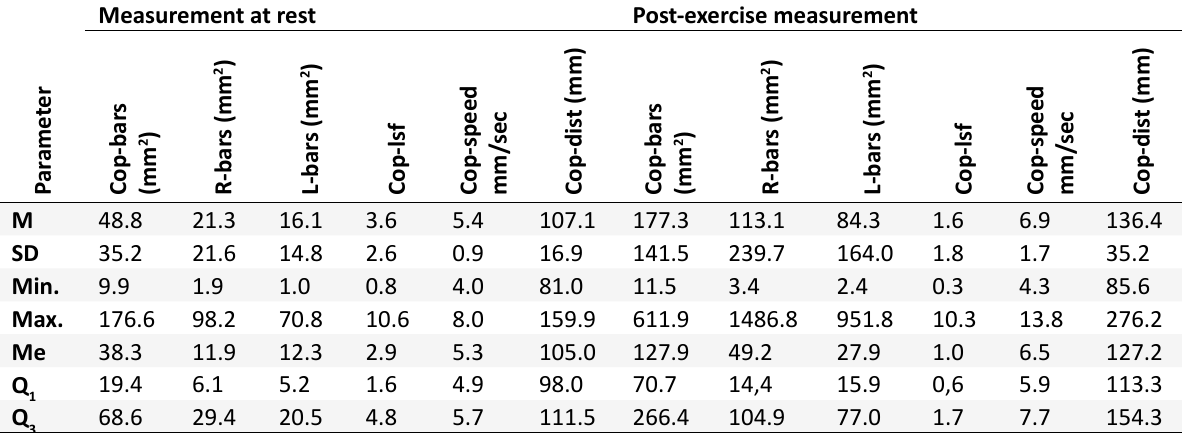
Legend: Cop-bars – surface of deflections of the body’s centre of gravity , R-bars – right foot deflection area, L-bars – left foot deflection area, Cop-lsf – ratio of the distance between extreme deflections to the deflection surface, Cop- speed – deflections speed of body’s centre of gravity, Cop-dist – distance between extreme deflections of the body’s centre of gravity, M – the arithmetic mean of a sample, SD – standard deviation, Min . – minimum value of a sample, Max . – maximum value of a sample, Me – the middle average of a sample, Q